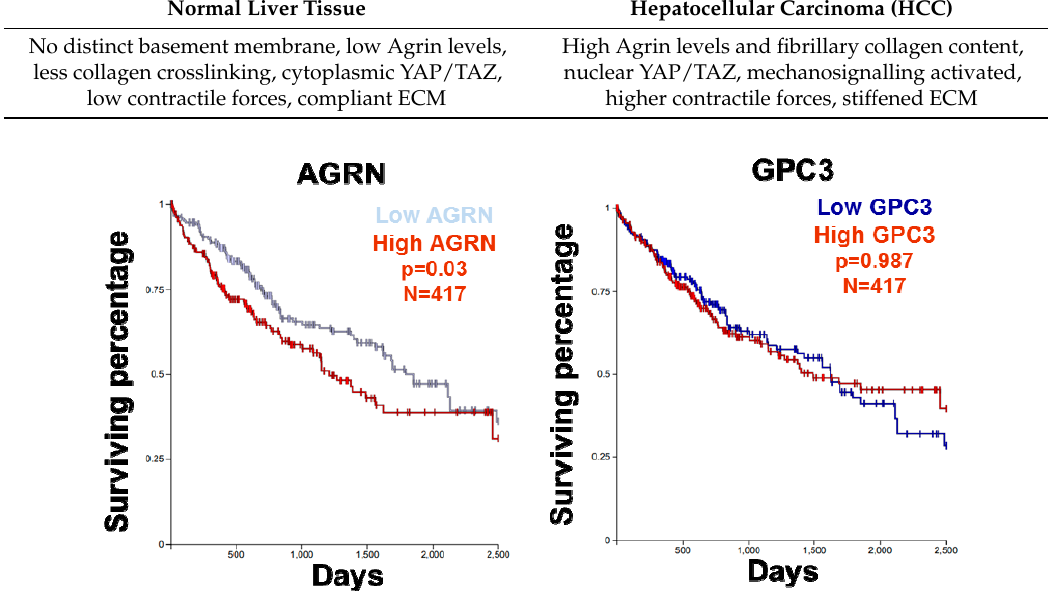
Figure 5. Survival analysis of HCC patients (TCGA datasets) with high or low level of agrin (AGRN) and glypican 3 (GPC3).